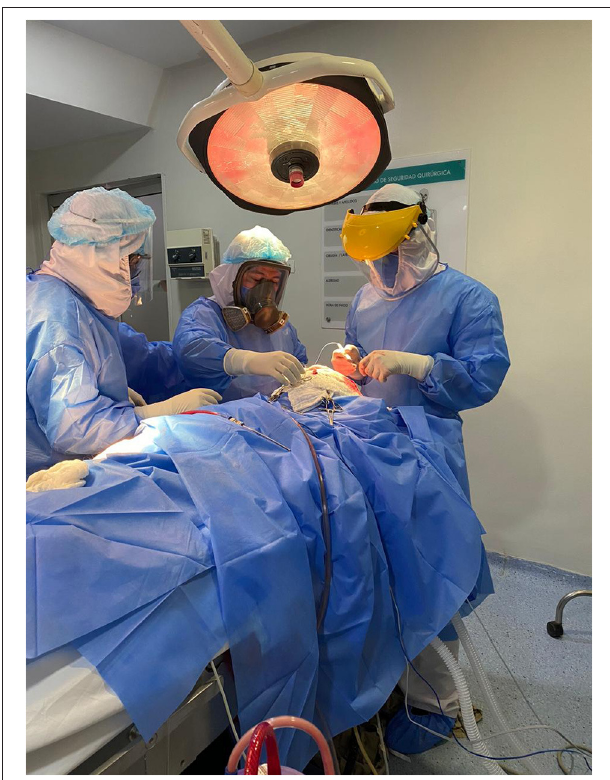
FIGURE 3 | Trauma surgery during COVID-19 pandemic. Dr. Santiago Morales, neurotrauma fellow (Colombia), and Dr. Andres M. Rubiano, fellow instructor (Colombia) performing an emergency cranial decompression on a patient with severe